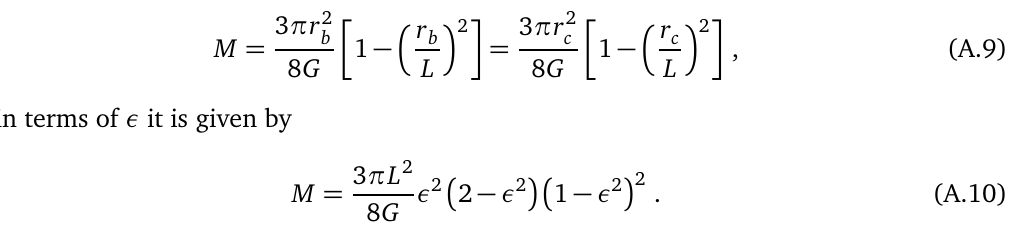
= − r in purple. d b